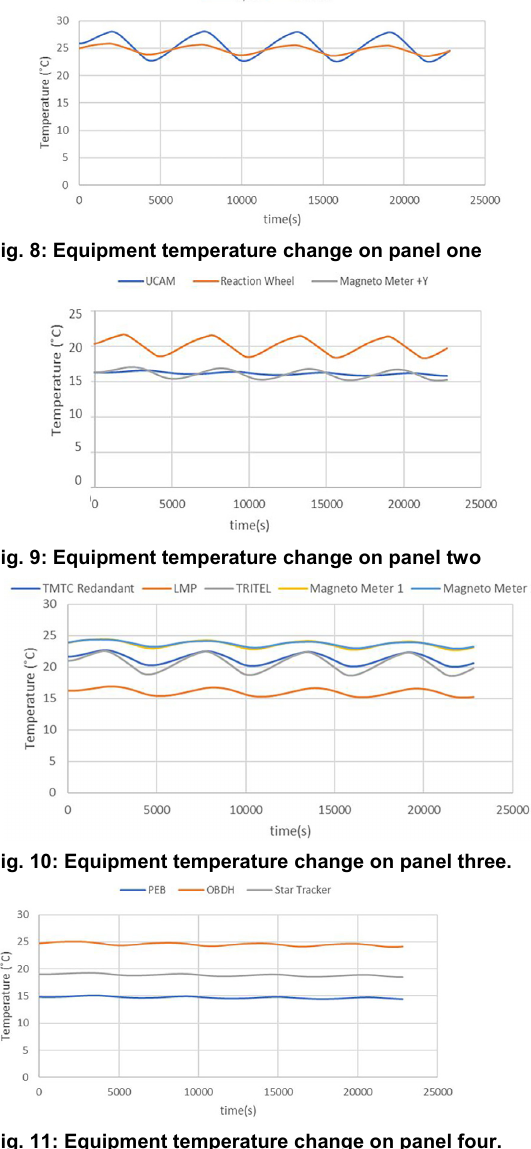
Fig. 11: Equipment temperature change on panel